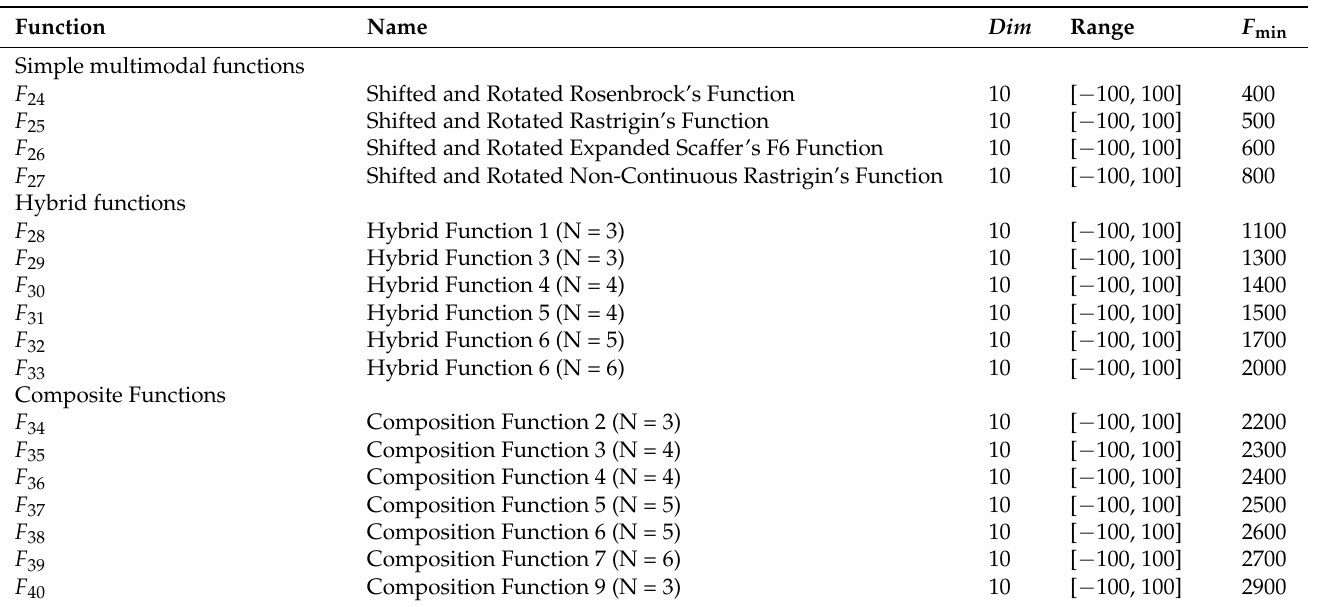
Table 8. Descriptions of 17 selected IEEE CEC2017 test functions.